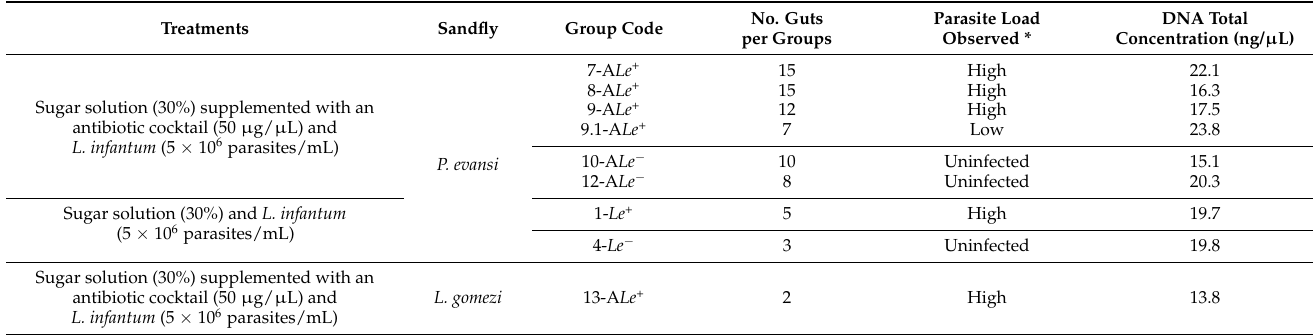
Table 1. Treatments and parasite load of L. infantum in gut groups of fed female P. evansi and L. gomezi from Ovejas, Sucre Department, Colombia. Treatments Sandfly Group Code No. Guts per Groups Parasite Load Observed * DNA Total Concentration (ng/ µ